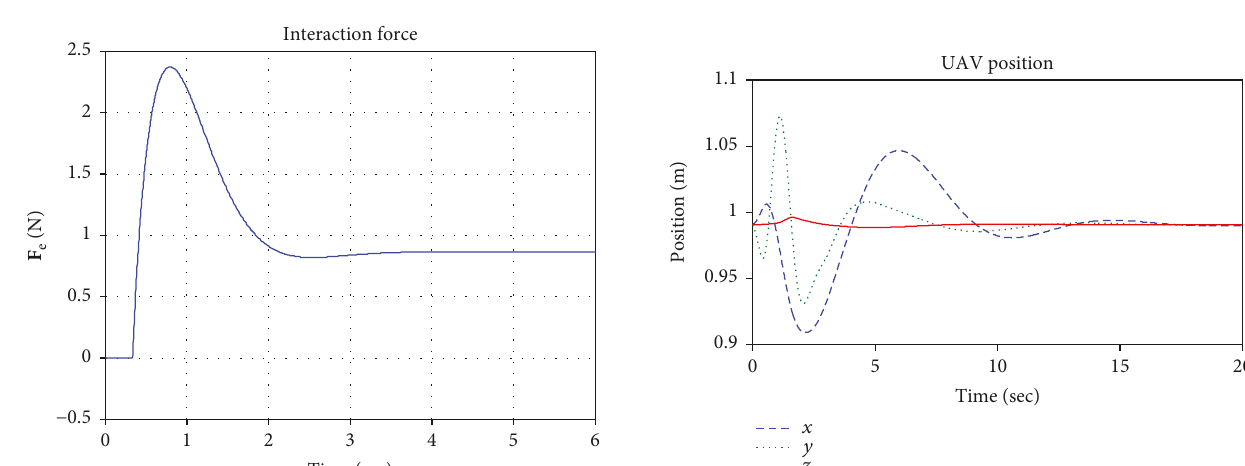
Figure 16: Joint torque for the manipulator.